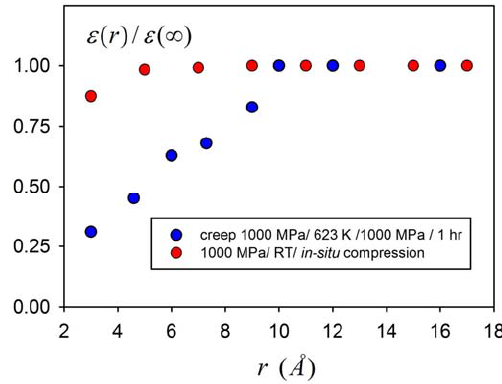
Figure 9. r ‐ dependent local strain determined from Equation (21) for the sample creep deformed at 623 K under 1 GPa for 1 h (blue), and for the sample under load of 1 GPa at room temperature (red).